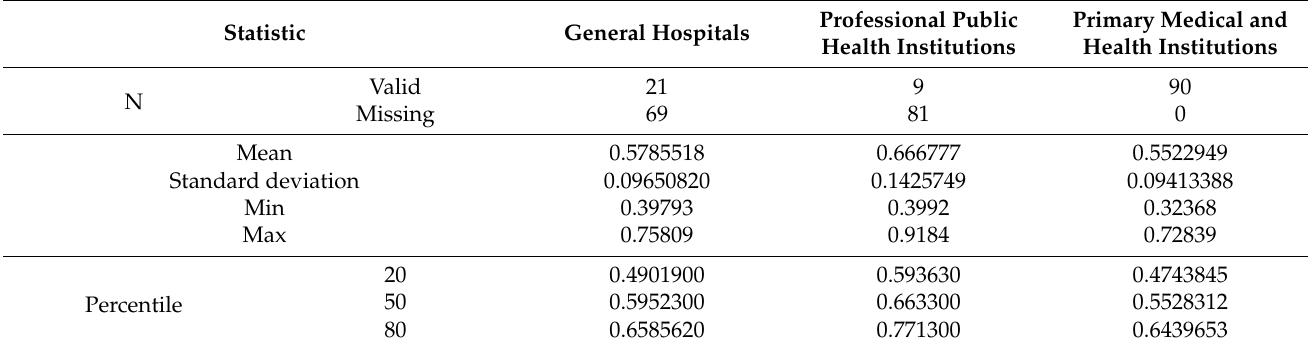
Professional Public